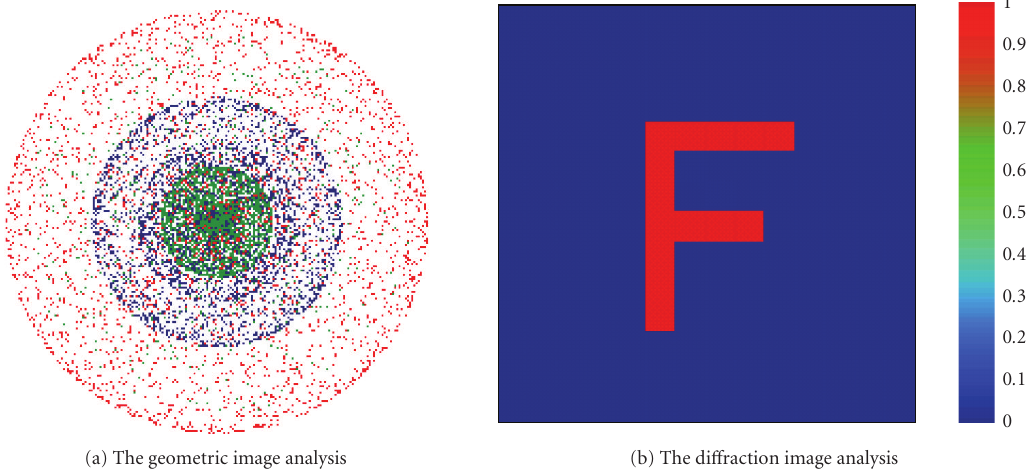
Figure 5: The geometric and di ff raction image analyses of the system illustrated in Figure